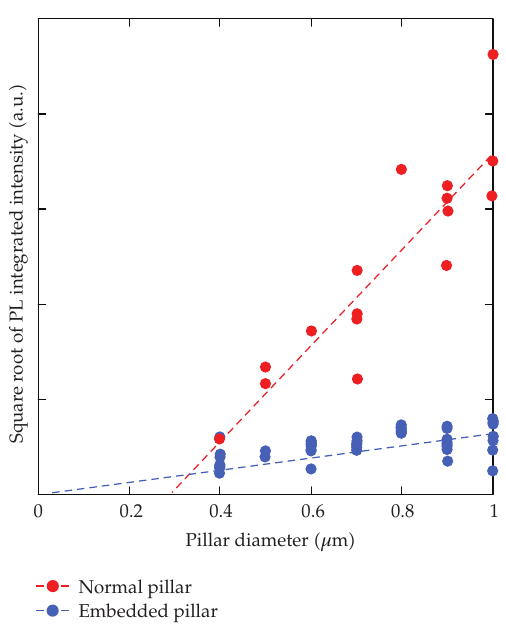
Figure 10: The pillar diameter dependence of the square root of PL integrated intensity. The fitting results by the least-square method are shown with the dashed line. The embedded pillar shows the 6.4-times increase of the slope. PL intensity is proportional to the luminescence area under the constant QD areal density. Thus the square root of PL integration intensity depends linearly on the pillar diameter. PL intensity is proportional to excitation rate (cid:5) G (cid:6) , internal quantum e ffi ciency, number of QDs, light extraction e ffi ciency (cid:5) C (cid:6) , and pillar cross section. Therefore, assuming the identical internal quantum e ffi ciency for √ CG , which reveals 40 (cid:5)(cid:8) 6 . 4 2 (cid:6) -times enhancement of both structures, the fitted slope is proportional to CG , that is, the photon extraction e ffi ciency including that of the excitation e ffi ciency. In the Nb embedded structure, 0.3 μ m shifts from the origin is observed. This suggests formation of optically inactive region about 0.15 μ m from the Nb